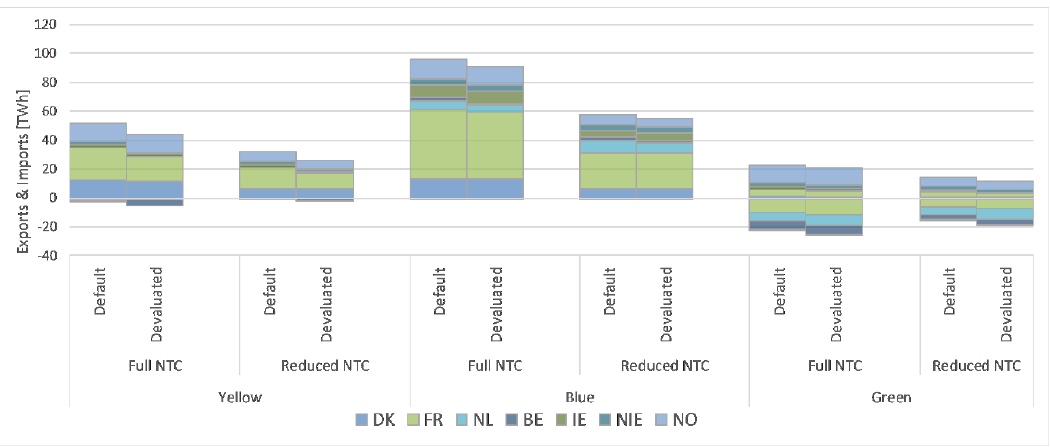
Figure 3. Electricity trade. Source: Own calculation.